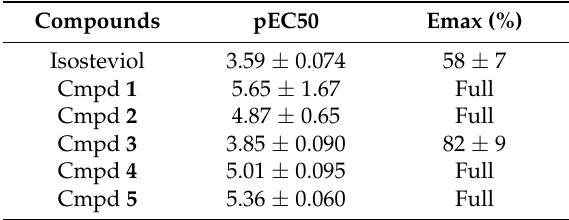
Figure 2. Changes of mitochondrial membrane potential (spectrofluorimetrically measured) following addition at cardiac mitochondria suspension (0.5 mg/mL) ( A , B ). Increase (%) in the rhodamine123-induced fluorescence after cumulative addition of isosteviol and compounds 1–5 ( C ). Table 1. Potency (pEC50) and efficacy (Emax %) indices measured for isosteviol and its triPP-conjugated derivatives (cmpds). Full = 100%.